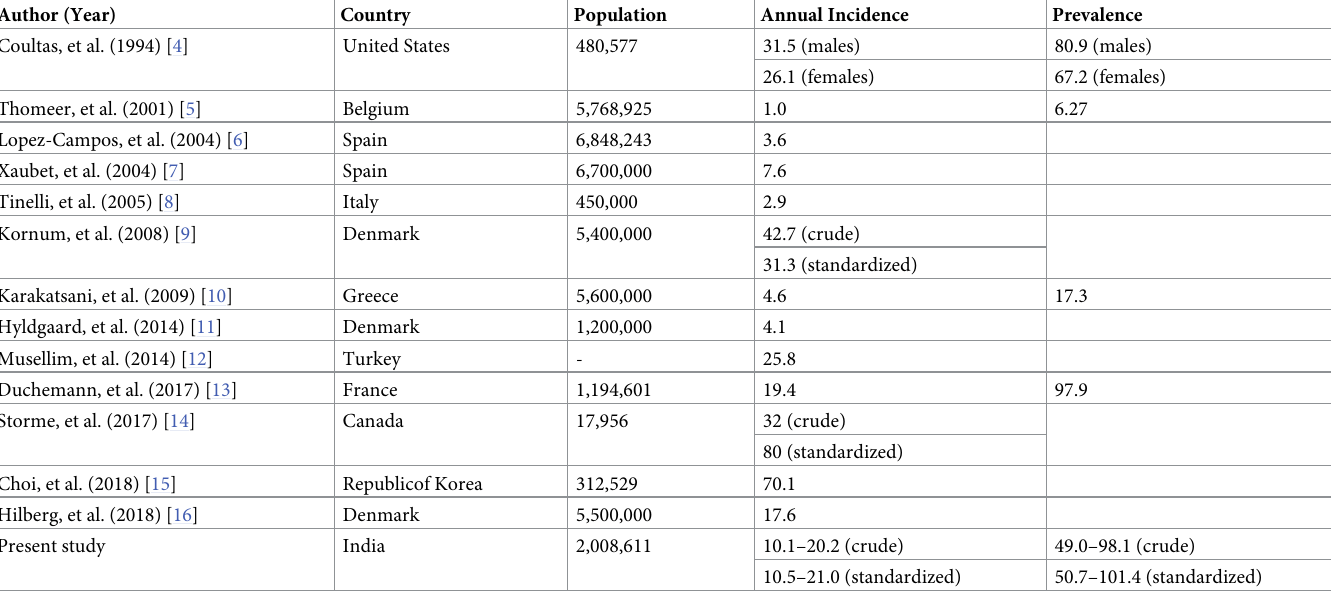
Table 7. Incidence of interstitial lung diseases found in previous studies.